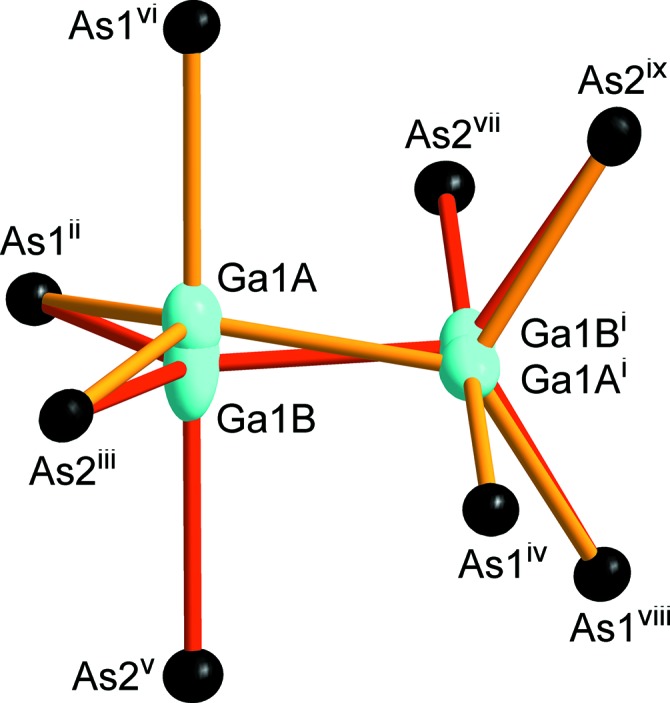
Ga2As6 groups with disordered Ga positions having an occupancy of 50%. Displacement ellipsoids are drawn at the 95% probability level. [Symmetry codes: (i) −x + 2, −x + y + 1, −z + ; (ii) y, x, −z + 1; (iii) x, y + 1, z + 1; (iv) y + 1, x + 1, −z + 1; (v) y + 1, x, −z + 1; (vi) −y + 1, x − y + 1 z + ; (vii) −y + 1, x − y, z + ; (viii) −y + 2, x − y + 1, z + ; (ix) −x + 2, −x + y + 2, −z + .]